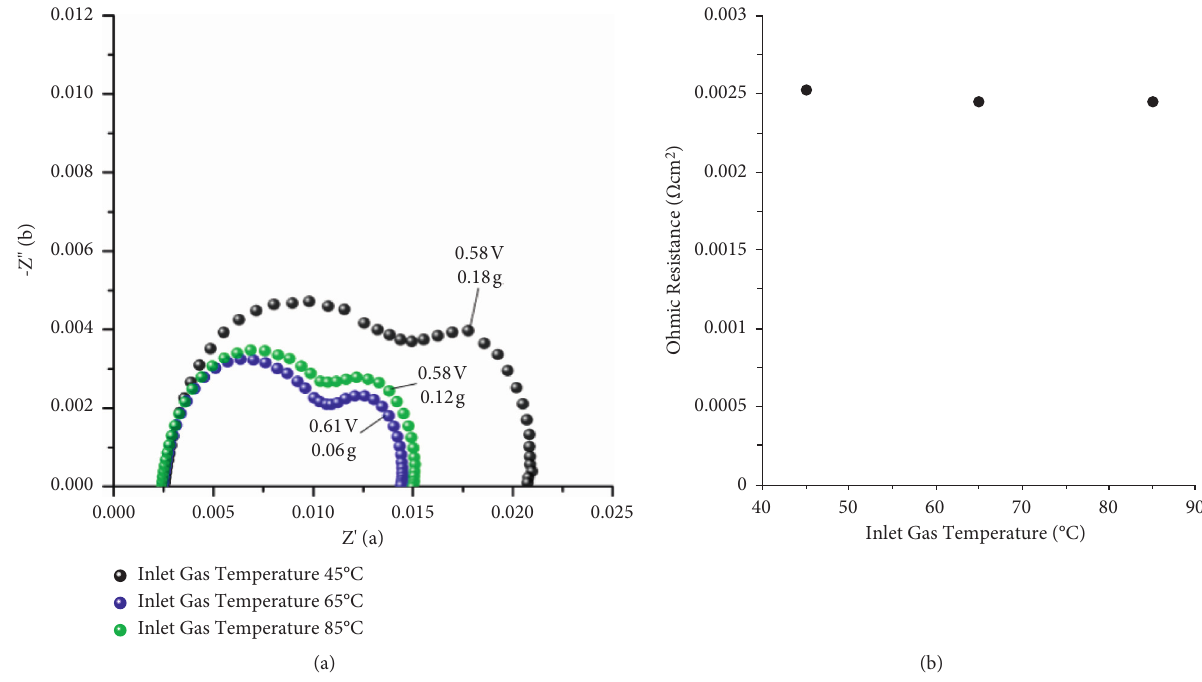
Figure 8: Effect of inlet gas temperature on the voltage, water content in the fuel cell, EIS, and ohmic resistance (inlet gas humidity 100%, hydrogen stoichiometry 1.5, and air stoichiometry 2.5). (a) EIS. (b) Ohmic resistance.